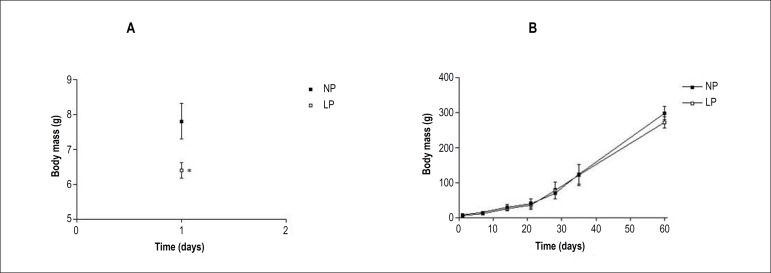
Effect of gestational protein restriction on the offspring weights.
(A) weights on day 1 of male offspring of rats fed a normal-protein
diet (NP, 17% protein, ■ symbol) or low-protein diet (LP, 6%
protein, symbol □) during pregnancy (X ± SD, * p =
0.0048 versus NP); (B) growth curve of the offspring from the 1st to
the 60th day after birth.